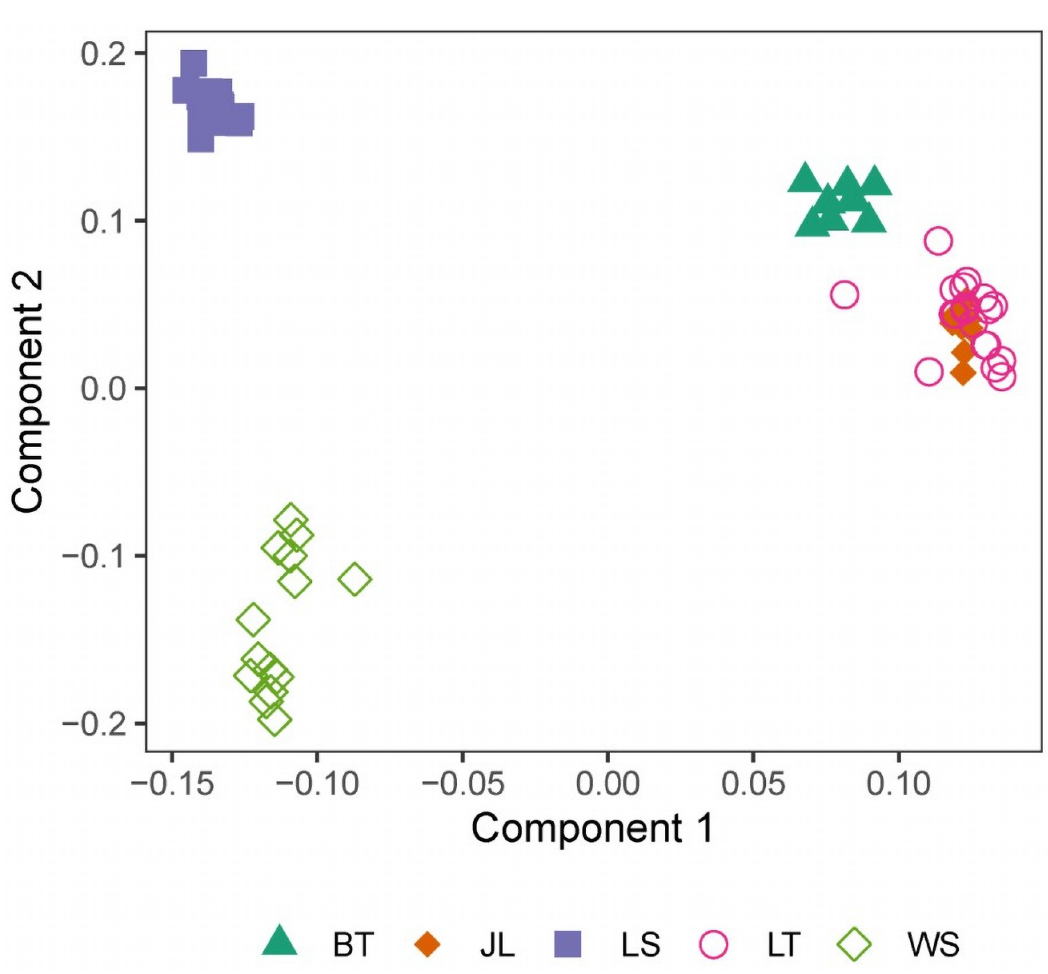
Fig 5. Sample clustering by IBS distance-based PCA